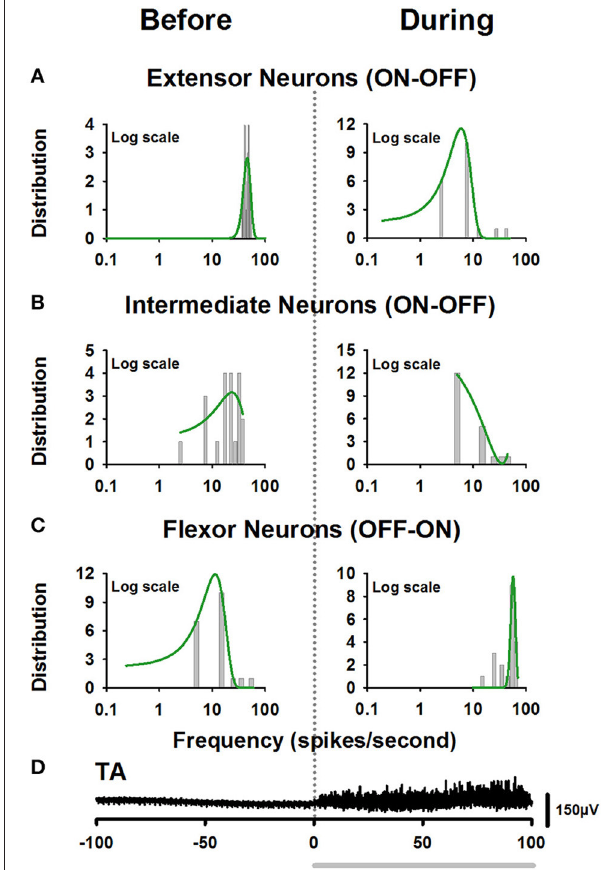
FIGURE 4 | Firing rate distributions obtained from the firing activity illustrated in Figure 3 . (A) Left panel, lognormal distribution of firing rate of extensor neurons before the onset of fictive scratching. The right panel shows the skewed lognormal distribution of firing rate, for the same extensor neurons after the onset of fictive scratching. (B) The same as Figure (A) , but for intermediate neurons. Note that these neurons did not exhibit a complete lognormal-firing-rate distribution. (C) The same as (A) , but for the flexor neurons. (D) Electroneurogram of the tonic flexor phase of the TA nerve (black). The gray horizontal line indicates the tonic flexor phase in the electrical activity of the TA